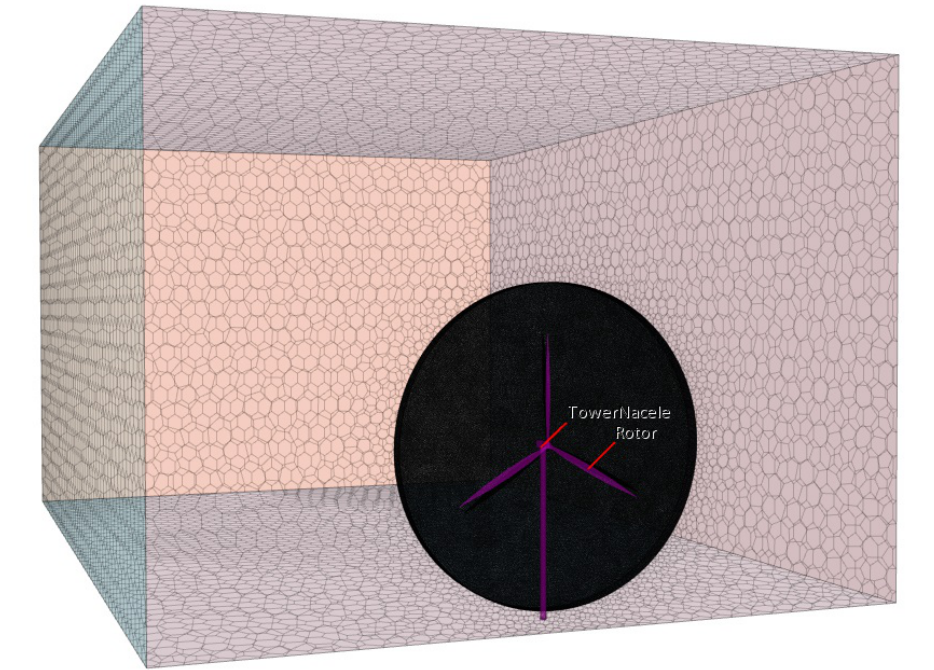
Figure 6. The wind tunnel mesh